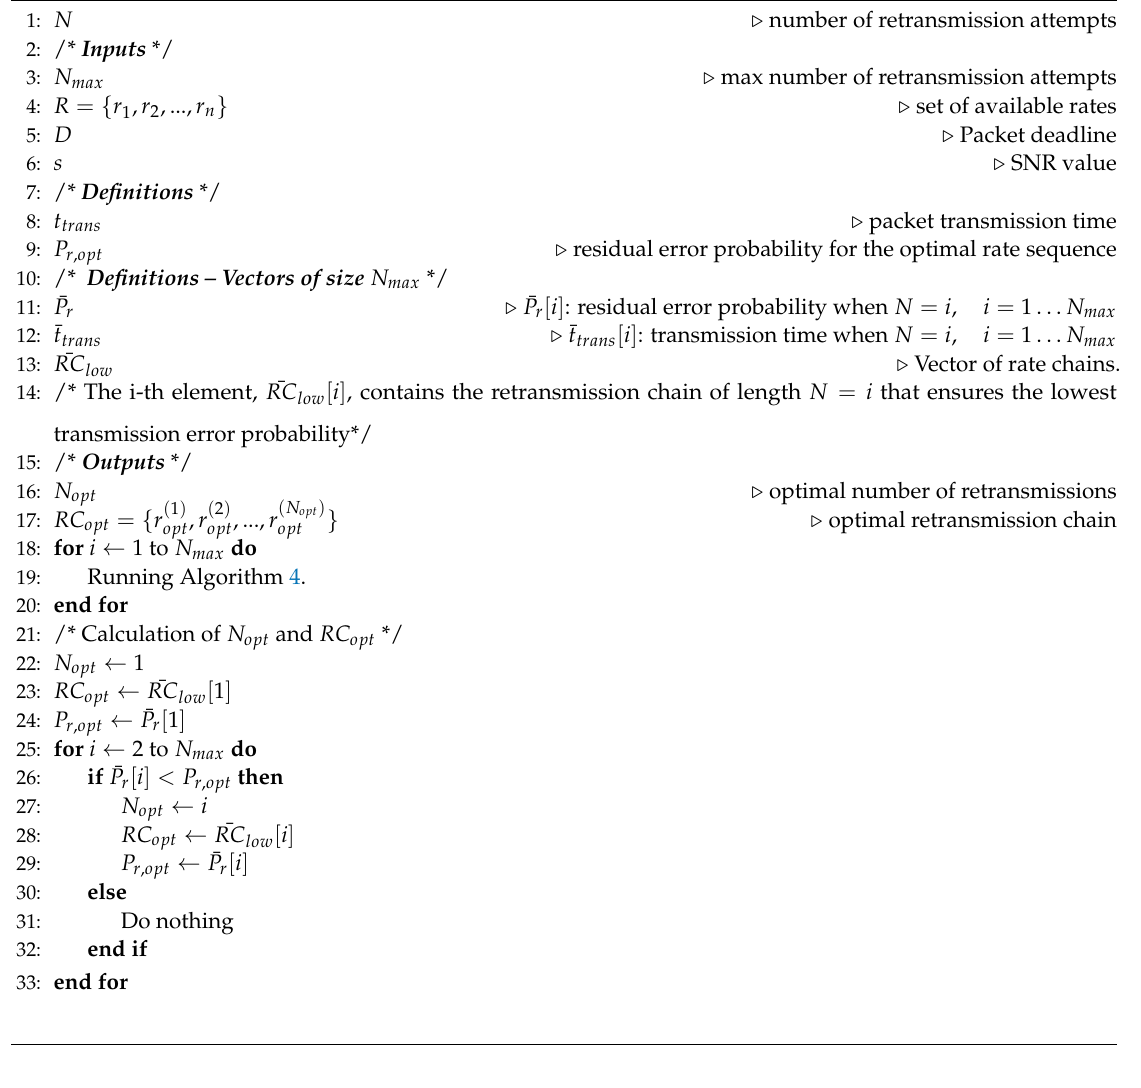
Algorithm 3 RSIN